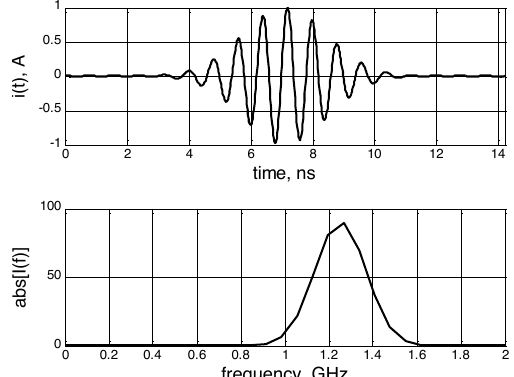
Figure 14: Transient plot of the considered excitation current i ( t ) and the frequency spectrum I ( f ).